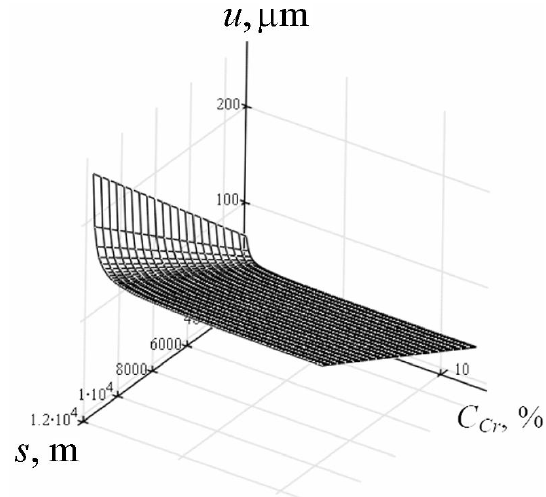
Fig. 3. The dependence of the wear of the auger u in the plane of the parameters of influence: the content of the chromium C Cr in the hardened steel and the friction path s